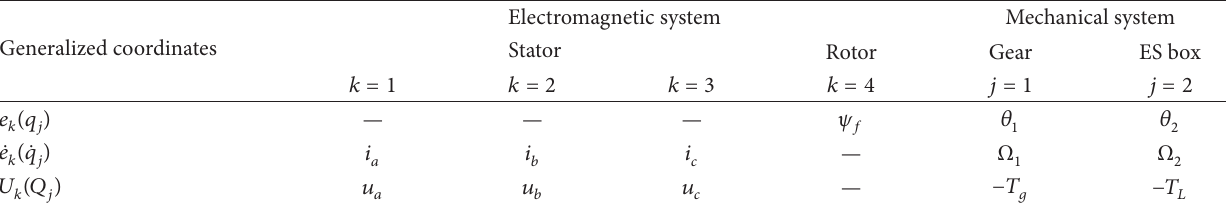
Table 1: Six generalized coordinates for MEES